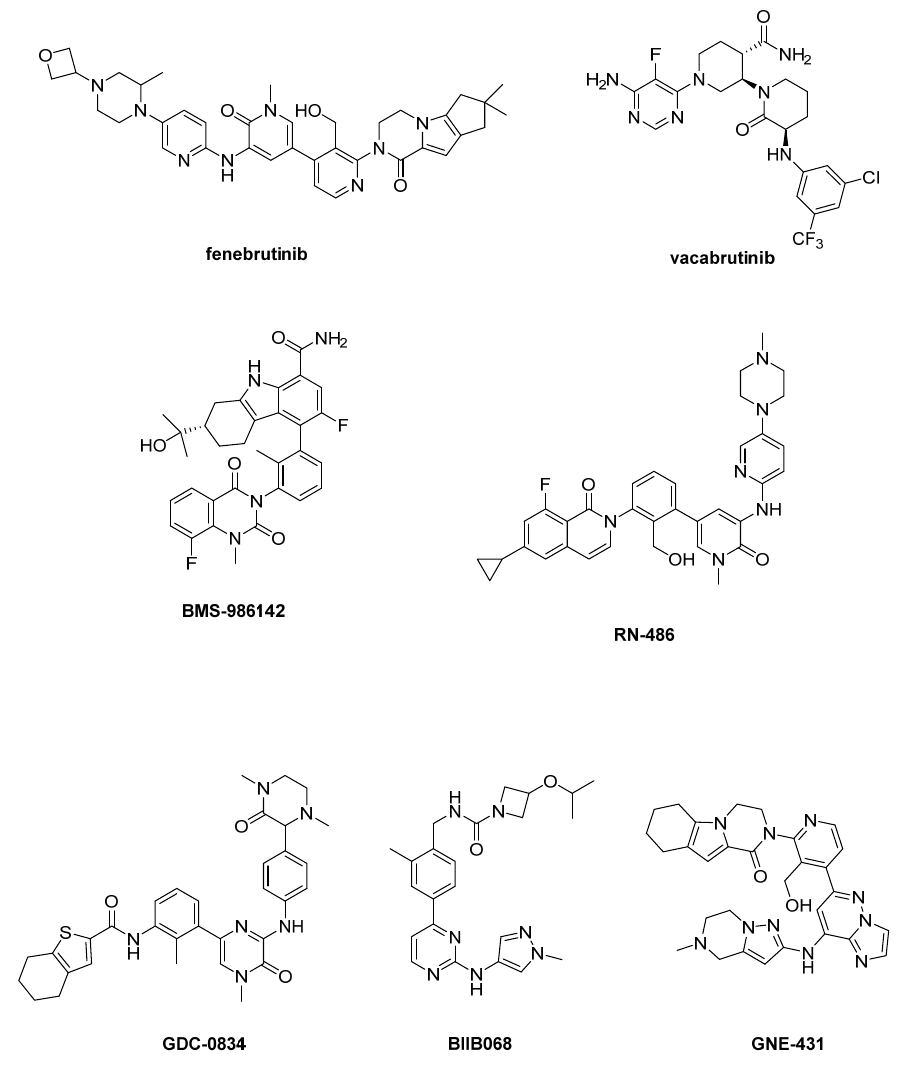
Figure 4. Reversible BtkIs under clinical investigation.